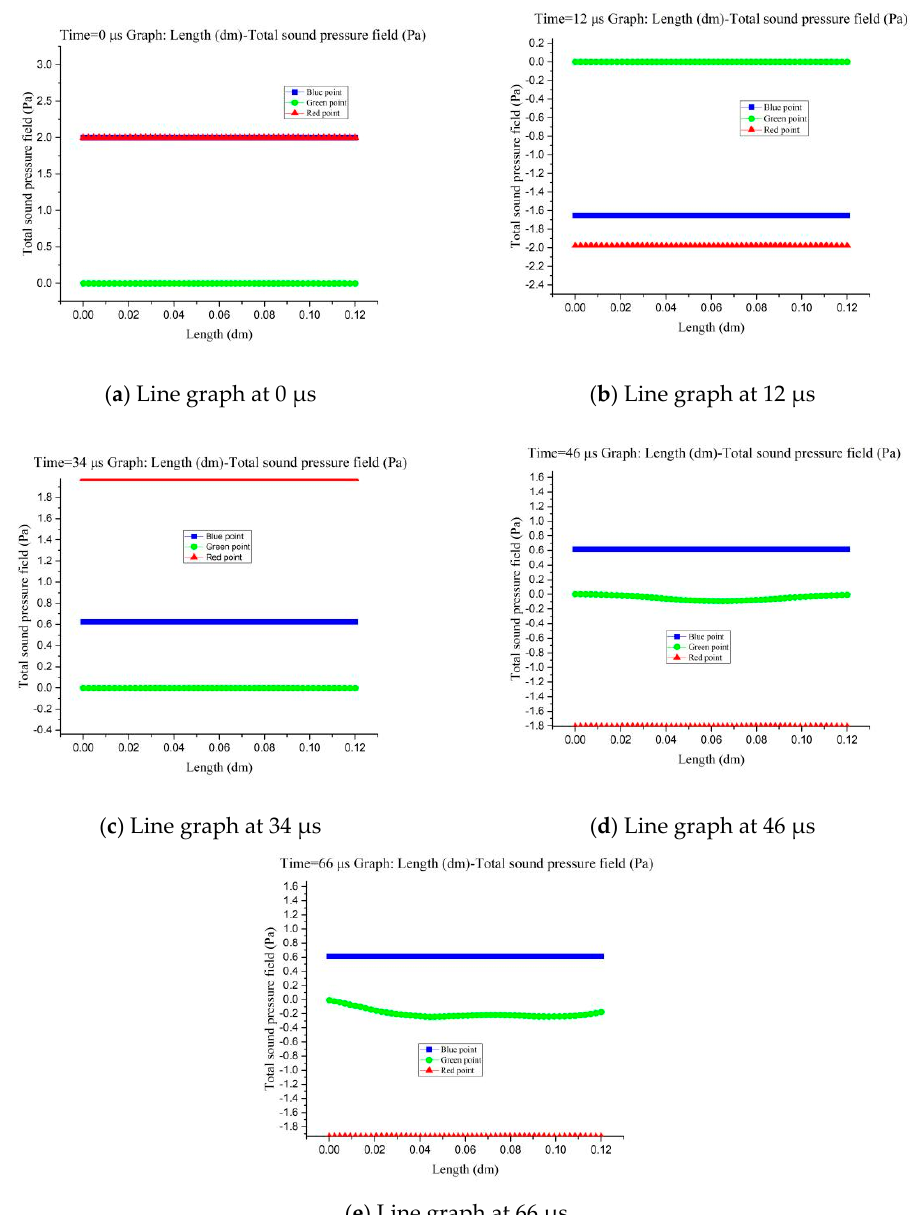
Figure 9. Changes in sound pressure at collection points at different times: ( a ) Line graph at 0 µs; ( b ) line graph at 12 µs; ( c ) line graph at 34 µs; ( d ) line graph at 46 µs; ( e ) line graph at 66 us.